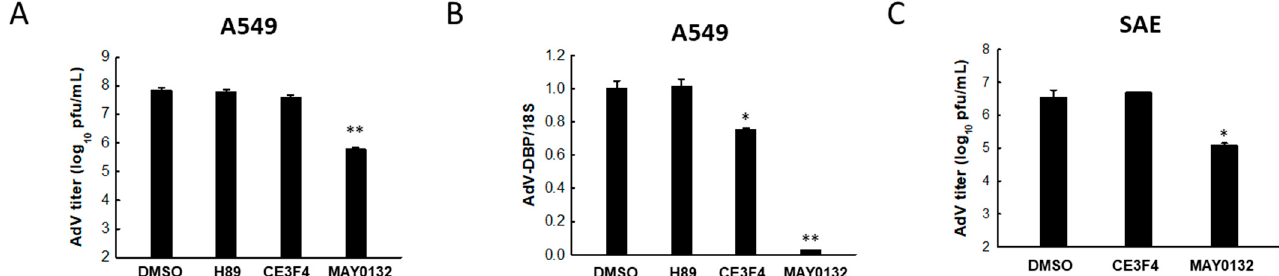
Figure 3. The impact of EPAC2 on AdV replication. ( A ) A549 cells in triplicate were infected with AdV at an MOI of 1. At 2 h p.i., cells were washed, followed by treatment with DMSO, 10 µ M H89, 10 µ M CE3F4, or 10 µ M MAY0132. At 48 h post-treatment, total viruses were harvested, and infectious AdV particles were quantified by the plaque assay using crystal violet staining. Data are representative of three independent experiments. ** p < 0.01, relative to the DMSO-treated group. ( B ) A549 cells in triplicate were infected with AdV and treated with drugs as described in ( A ). At 48 h post-treatment, total RNA was extracted and subjected to qRT-PCR to measure AdV-DBP gene expression. 18S rRNA was used for normalization. * p < 0.05 and ** p < 0.01, relative to the DMSO-treated group. ( C ) SAE cells were infected with AdV at an MOI of 1 and then treated with DMSO, 10 µ M CE3F4, or 10 µ M MAY0132. At 48 h post-treatment, total viruses were prepared, and infectious AdV particles were quantified by the plaque assay. Data are representative of three independent experiments. * p < 0.05 and ** p < 0.01, relative to the DMSO-treated